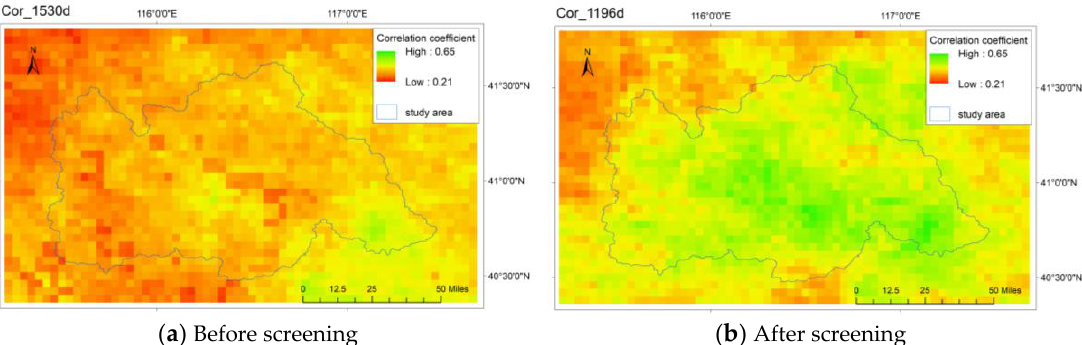
Figure 2. Spatial distribution of the correlation coefficients for the measured precipitation data and remote sensing precipitation data. Table 1. Correlation coefficients between the measured precipitation and remote sensing precipitation time series data.